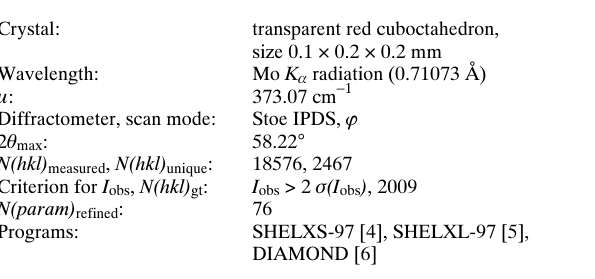
1. (cid:1) -Antimony dimercury tetrachloroaluminate, SbHg Table 1. Data collection and handling.